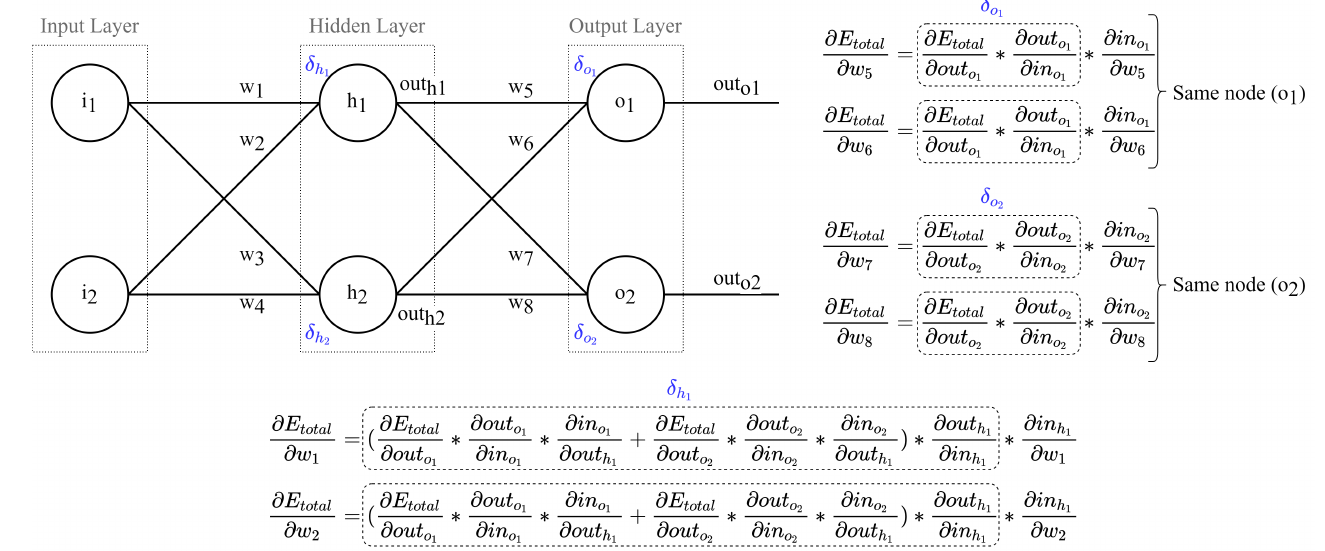
Figure 2. Node delta parameter in the chain-rule of SGD.